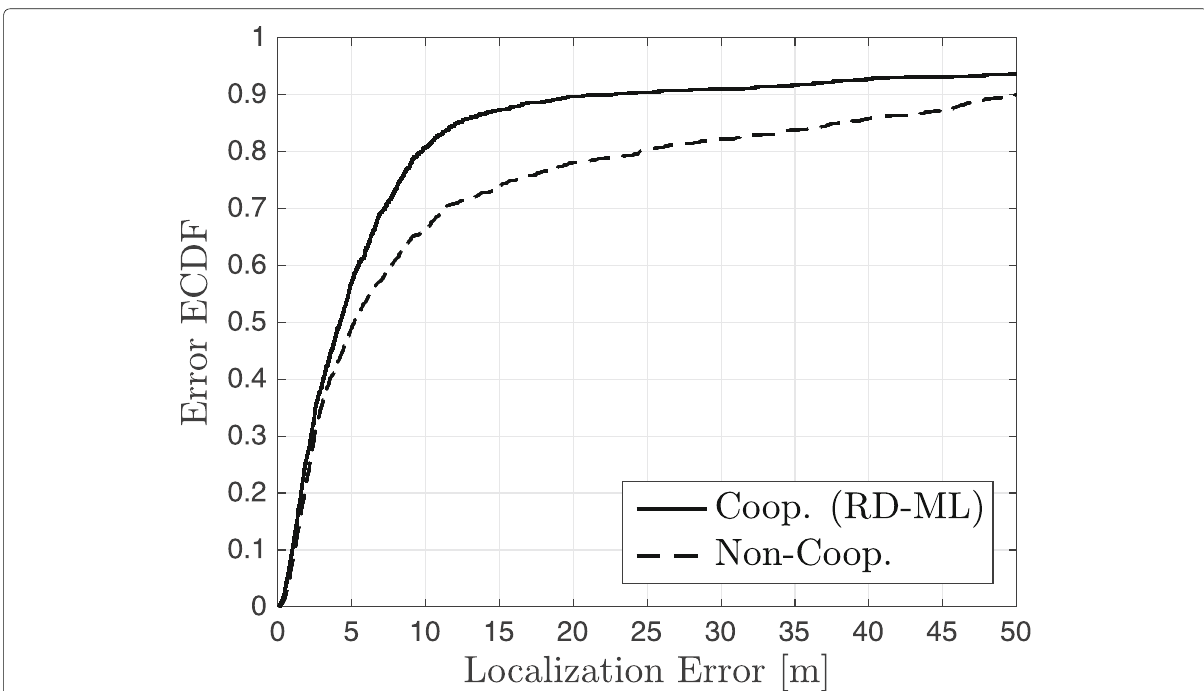
Fig. 8 Cooperative (RDML) and non-cooperative approaches in a mixed LoS/NLoS scenario, in a network with communication radius R = 70 m,